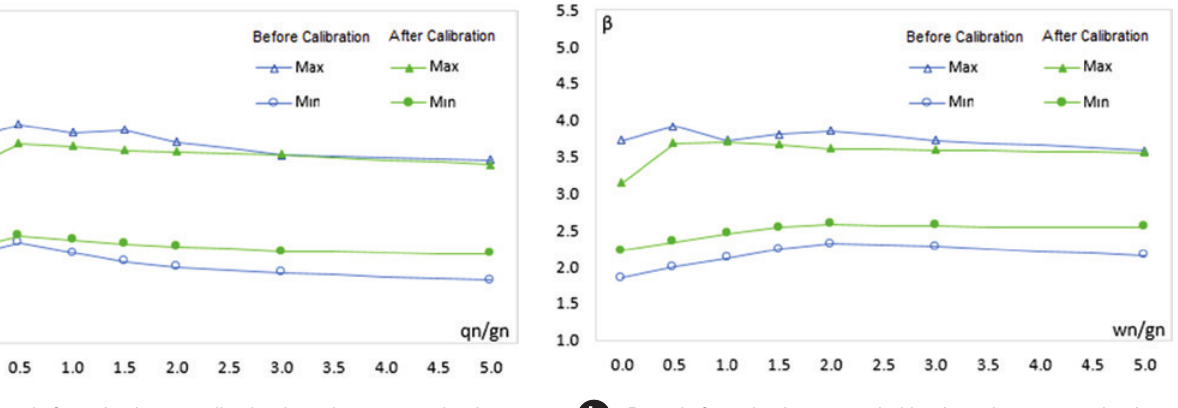
Bounds for ratios between live loads and permanent